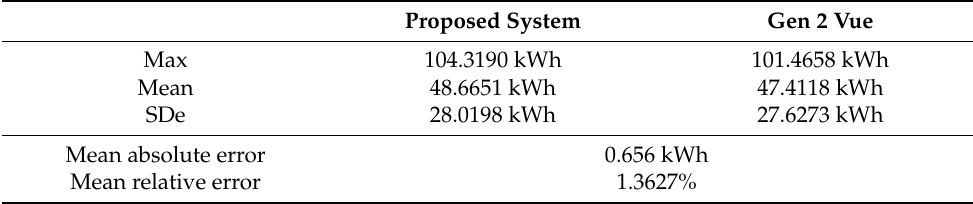
Table 11. Active energy data in line 2 obtained by both monitors.